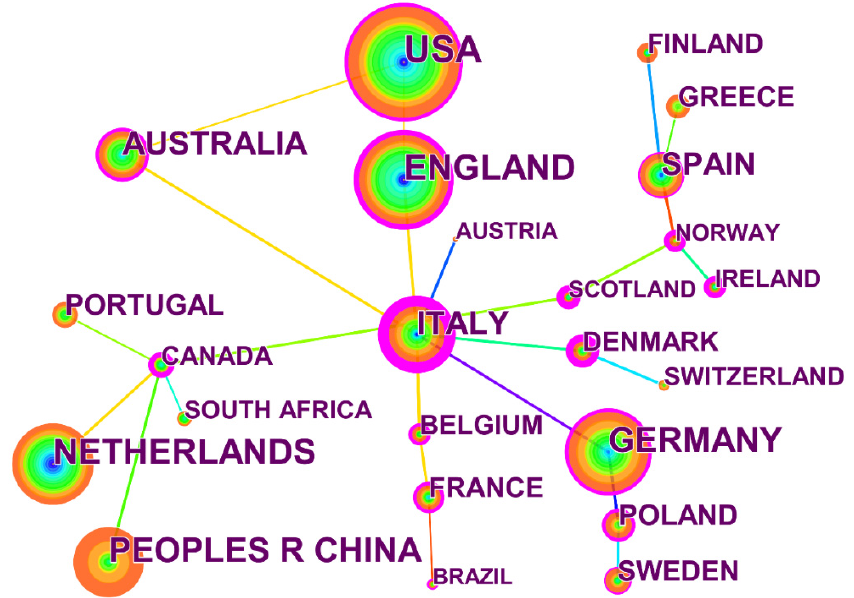
Figure 5. Visualization of the country collaboration network (WOSCC).